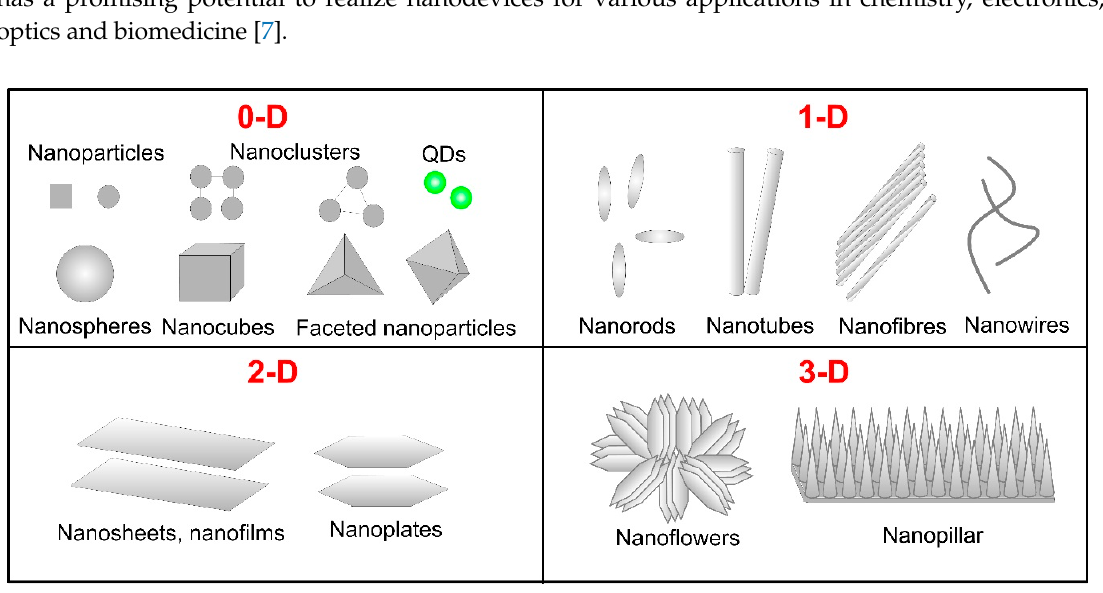
Figure 1. Scheme of zero-, one-, two- and three-dimensional nanostructured materials with di ff erent morphologies. 0-D, 1-D, 2-D, and 3-D indicate zero-, one-, two- and three-dimensional NPs, respectively.